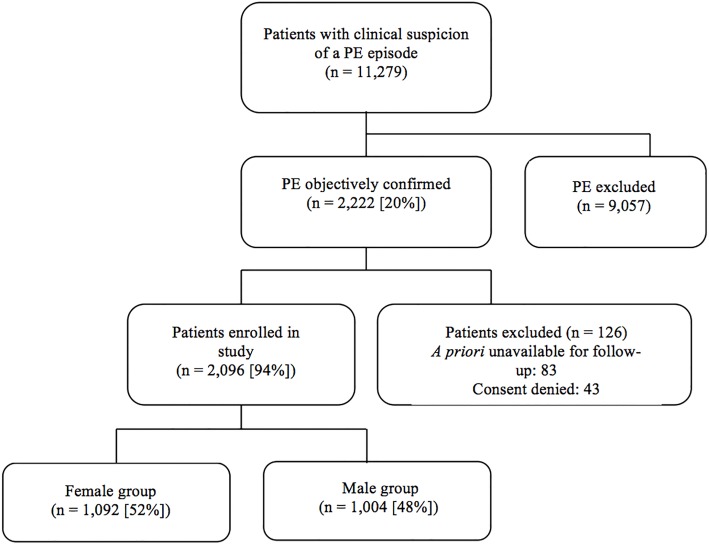
Patient flow diagram.